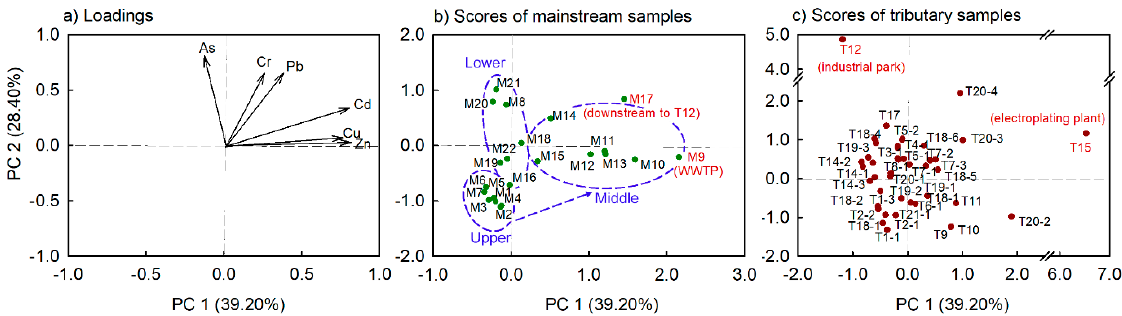
Figure 4. ( a ) Loading and ( b , c ) score plots of six dissolved metal(loid) concentrations in the mainstream and tributary samples of the Maozhou River based on principal component analysis (PCA).